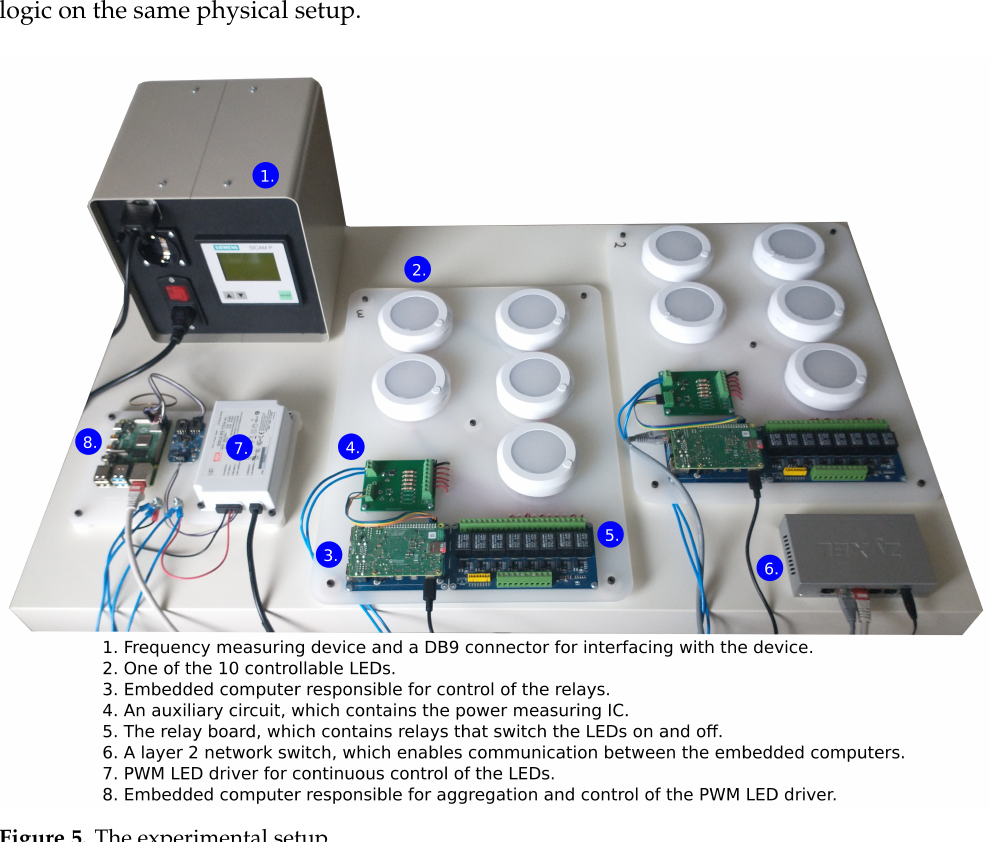
Figure 5. The experimental